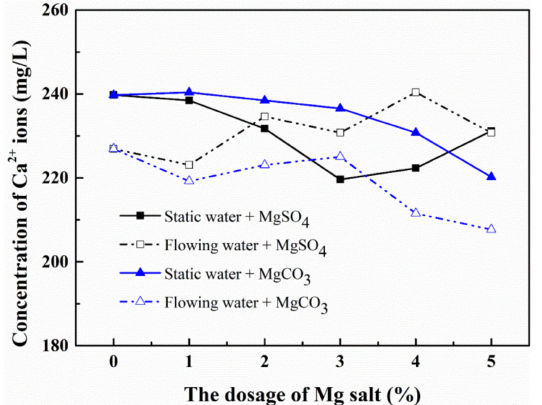
Figure 4. The e ff ects of magnesium salts on the concentration of Ca 2 + ions in the magnetized CaCl 2 -NaHCO 3 mixed